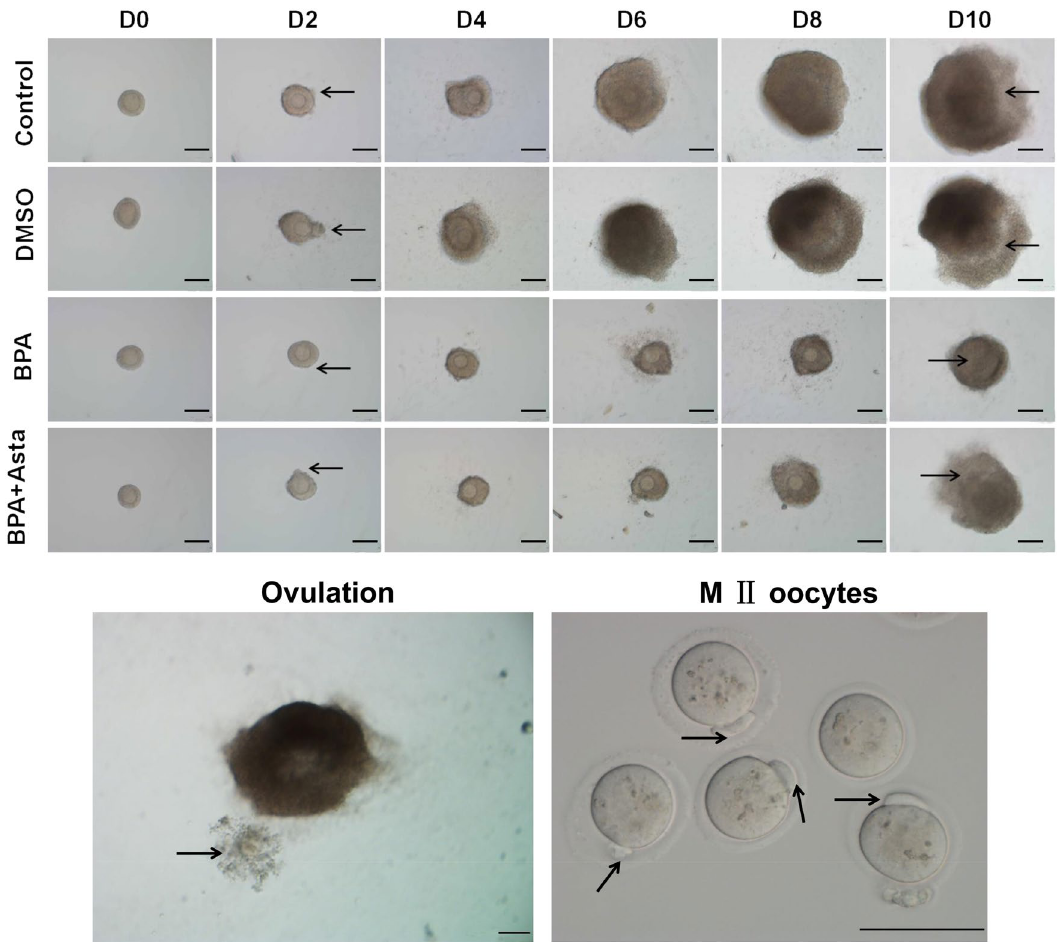
Figure 1. The in vitro development of follicles at various stages (Scale bar, 100 mµ). On D2, the arrow head indicated the outgrowth of the adhered follicular cells; On D10, the arrow head indicated the follicular antrum; In the picture of ovulation, the arrows indicated the ovulated cumulus-oocyte complexes (CoCs); and in the picture of M II oocytes, the arrows indicated the first polar body excreted by mature oocytes.